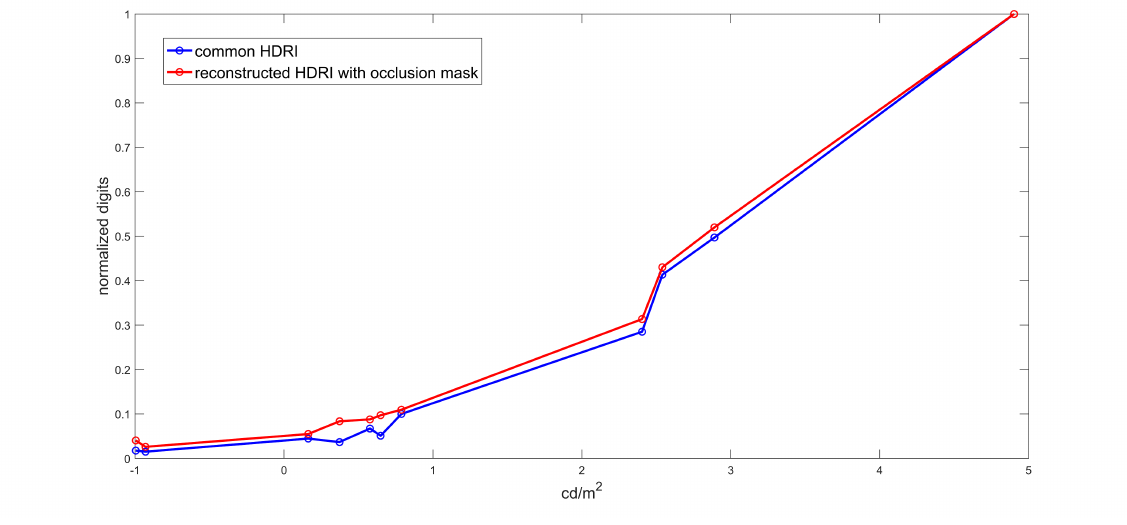
Figure 9. Ratio between luminous intensity and its corresponding digit for both curves.